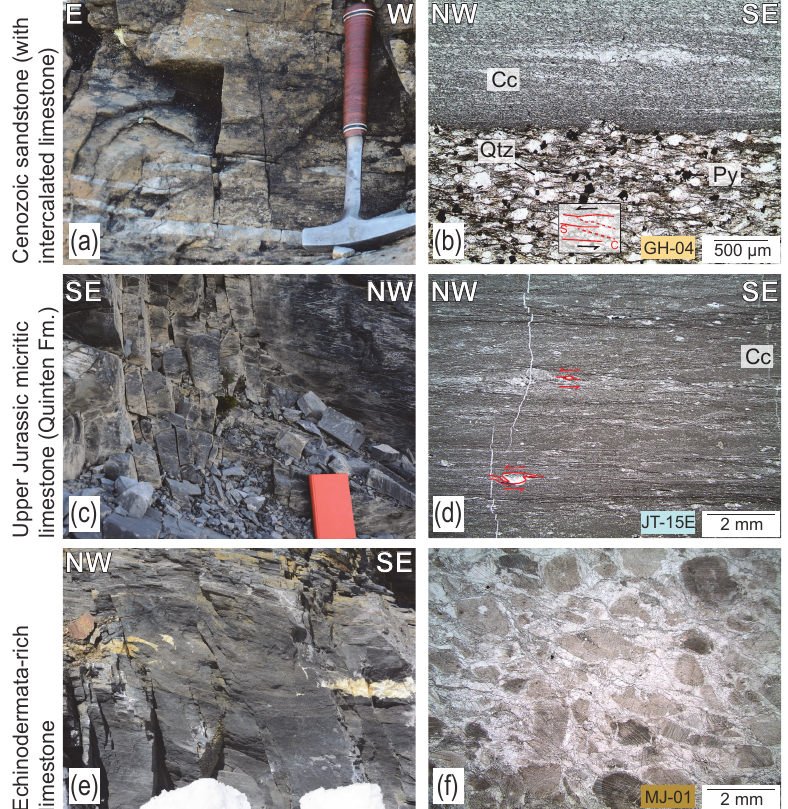
Figure 8. Deformation structures on outcrop and microscale. (a) Ultra-mylonitic Tertiary sandstones intercalated with calcite limestones that (b) show a dynamically recrystallized fabric in the limestone part, while the quartz within the S-C mylonite exhibits still (semi-) brittle behavior. This manifests in mylonitic ductile shear bands formed by micas and calcite while quartz grains (along with pyrite) form sigmoidal clasts. (c) Dark micritic limestone mylonites of the Upper Jurassic B unit with a (d) completely recrystallized fabric of microcrystalline calcite. (e) Echinodermata-rich limestone of the Middle Jurassic show the low P , T overprint with (f) undeformed echinodermata, probably due to consisting of magnesium calcite, which makes these minerals stronger (Xu et al., 2009). Mineral abbreviations: Cc – calcite, Qtz – quartz, Py –